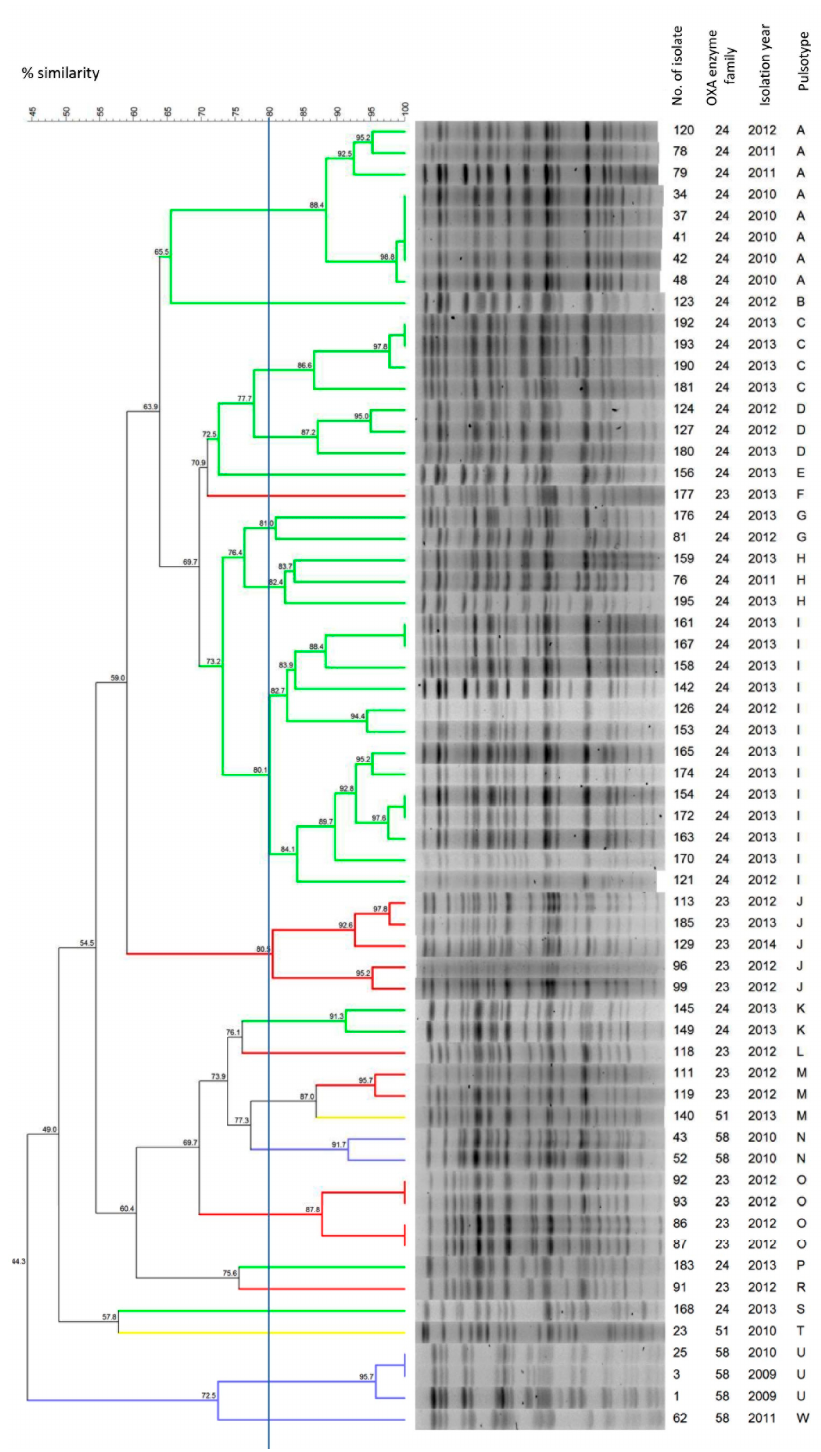
Figure 2. Analysis of pulsed field gel electrophoresis (PFGE) patterns. The dendrogram presents PFGE profiles’ percentage similarity, the presence of the OXA enzyme family and the isolation year of the A . baumannii clinical isolates. The solid line indicates 80% similarity and is used to define the pulsotypes. Isolates carrying different groups of the acquired bla CHDL genes were marked with the following colors: red, bla OXA-23-like ; green, bla OXA-24-like ; and blue, bla OXA-58-like . Isolates harboring only intrinsic bla OXA-58-like gene were marked in